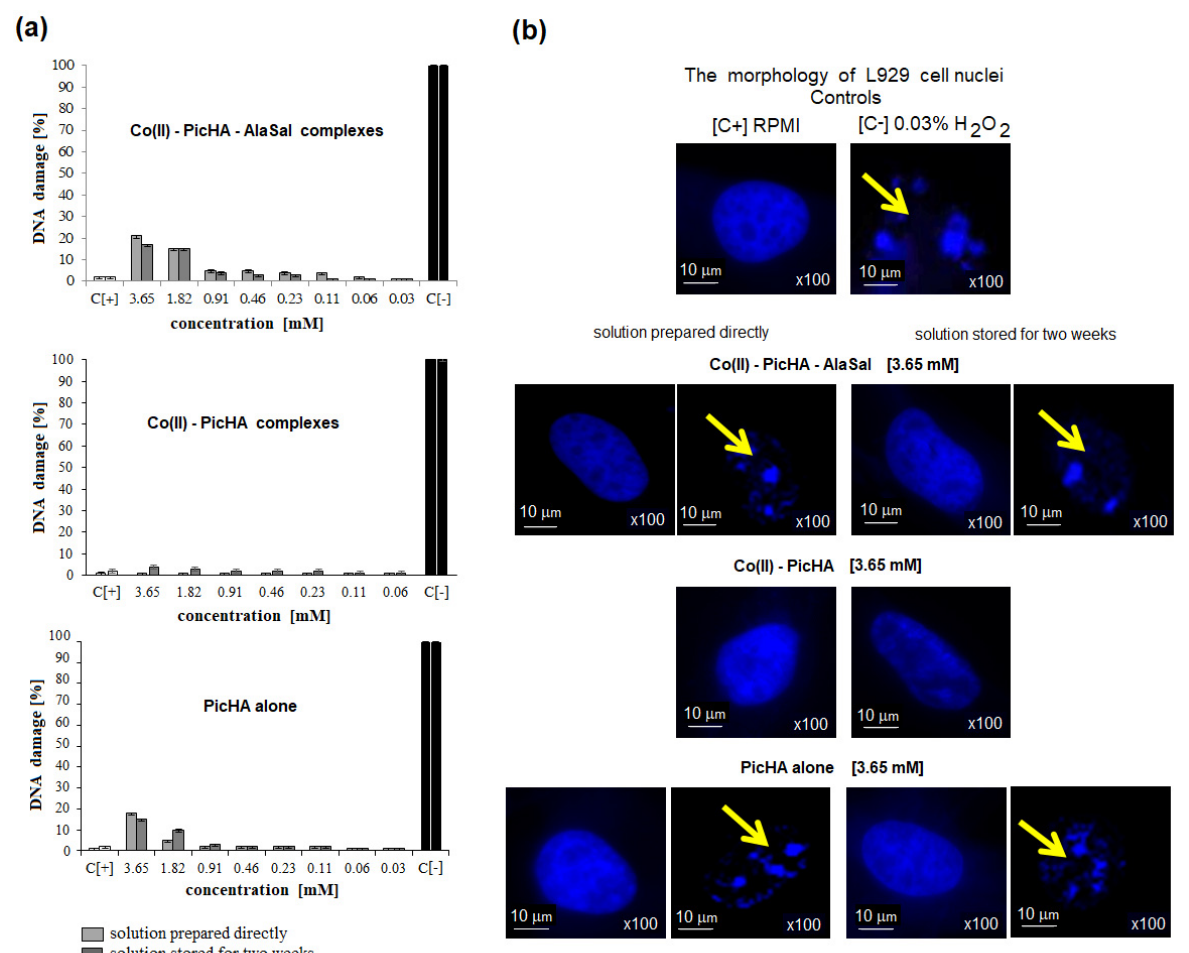
Figure 6. Percentage of L929 cells with vesicular cell nuclei ( a ) and representative microscopic images of L929 cells with signs of cell nuclei damage ( b ). The cells were stimulated for 24 h with complex or ligand forms. Cell cultures in complete RMPI-1640 medium (cRPMI) were used as positive controls (C+): cells with no signs of cell nuclei damage; cells treated with 0.03% H 2 O 2 were used as negative controls (C − ): cells with DNA damage. The morphology of cell nuclei was assessed by 4 ′ ,6-diamidino-2-phenylindole (DAPI) staining. Samples were viewed under a fluorescent microscope at 100 × magnification (Axio Scope A1, Zeiss). Data are presented as mean values ± SD. Yellow arrows indicate cells with signs of cell nuclei degradation.